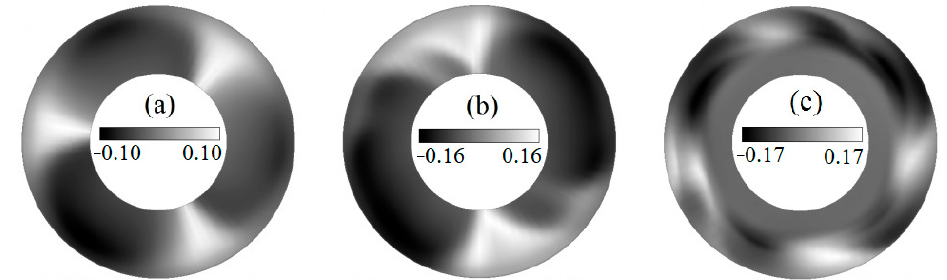
Figure 5. Overview of surface solute concentration fluctuation on the free surface at Re c = 0 and Re T = 10 4 . ( a ) Re s = − 4.7 × 10 2 ; ( b ) Re s = − 1.8 × 10 3 ; ( c ) Re s = − 2.3 × 10 3 .